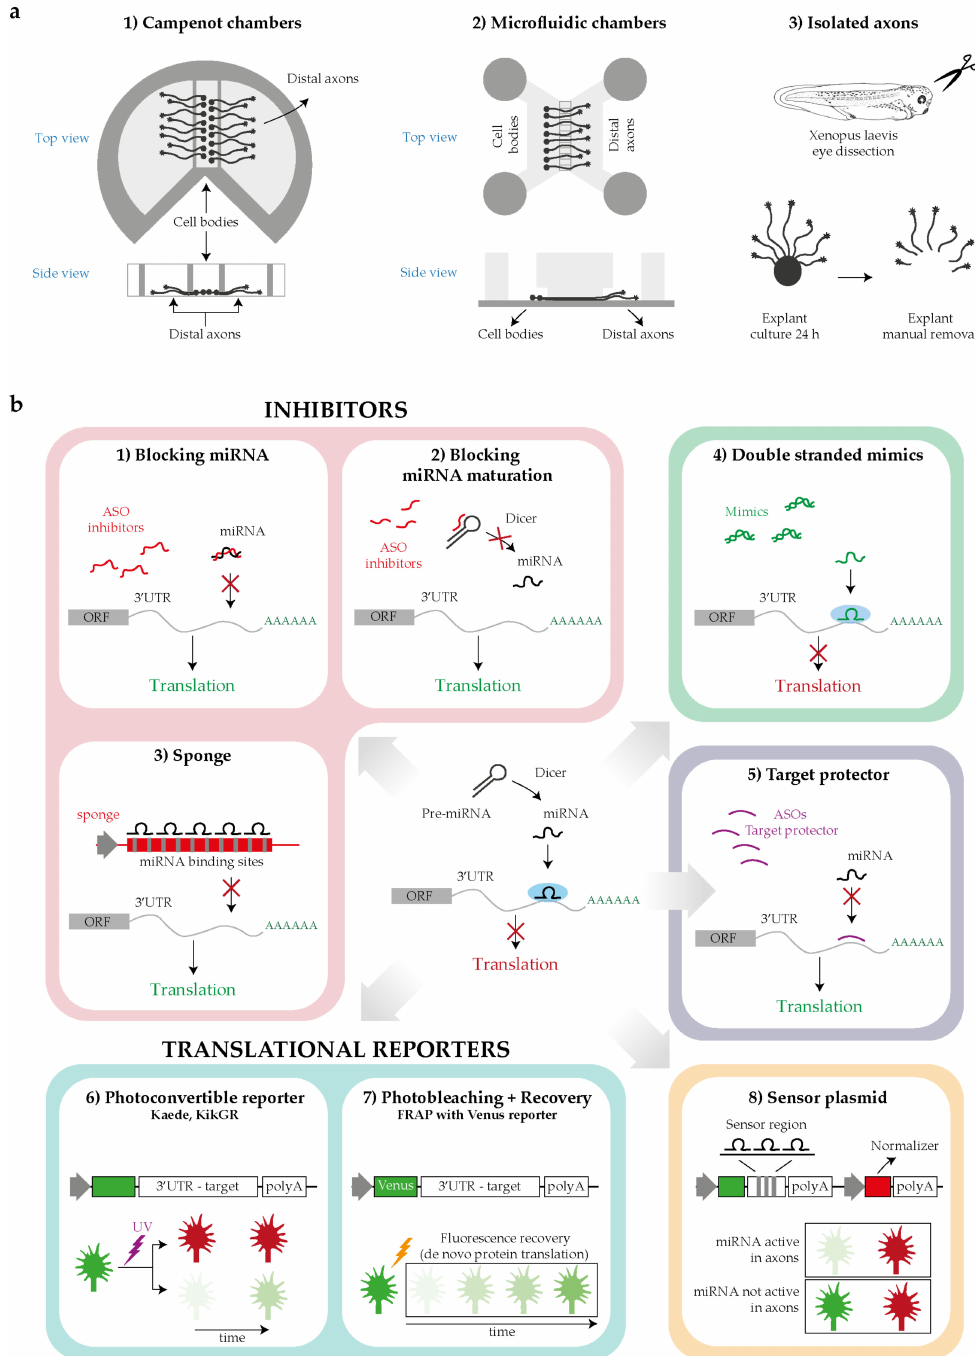
Figure 4. Tools for investigating the intra-axonal roles of miRNAs. ( a ) Schematics for distal axons isolation: Campenot chambers, microfluidic devices or manual removal of the explants in case of organoculture. ( b ) Techniques for studying miRNA function: by loss of function (LOF) approach blocking miRNA function (1–3), by gain of function (GOF) approach increasing miRNAs level with mimics (4); by blocking miRNA target recognition, masking the miRNA-responsive element (MREs) withatargetprotector(5); bystudyingwithreportersthetranslationaleventspotentiallyregulatedbythe miRNA under study (6,7); by measuring the miRNA activity using sensor plasmids (8). Abbreviations: ORF, open reading frame; ASOs, antisense